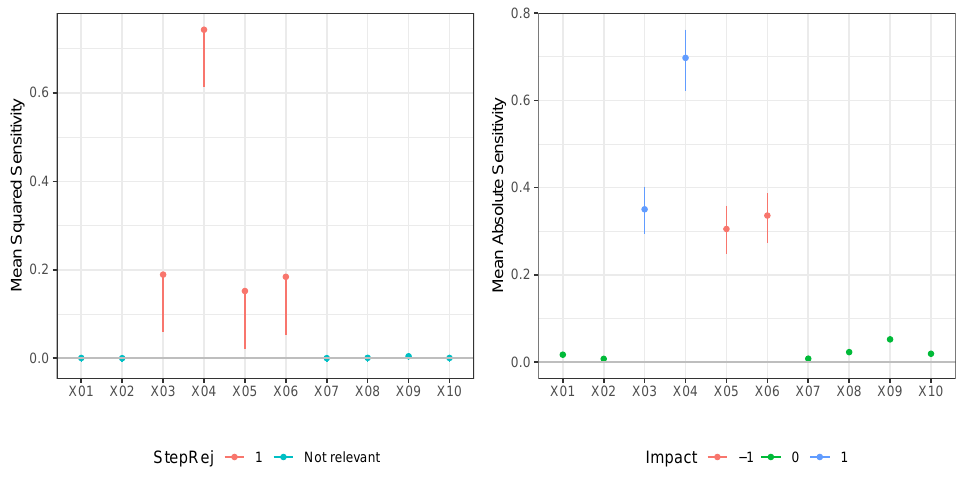
Figure 1. Model M1 (Tibishirani). Case n = 300. ( left ) Values of test statistic T n and critical values T n − ˆ c ( 1 − α , k ) . ( right ) Values of mean absolute sensitivity along with bootstrap confidence limits with B = 1999 bootstrap replicates and nominal level 1 − α = 0.90 for those variable that are relevant to the